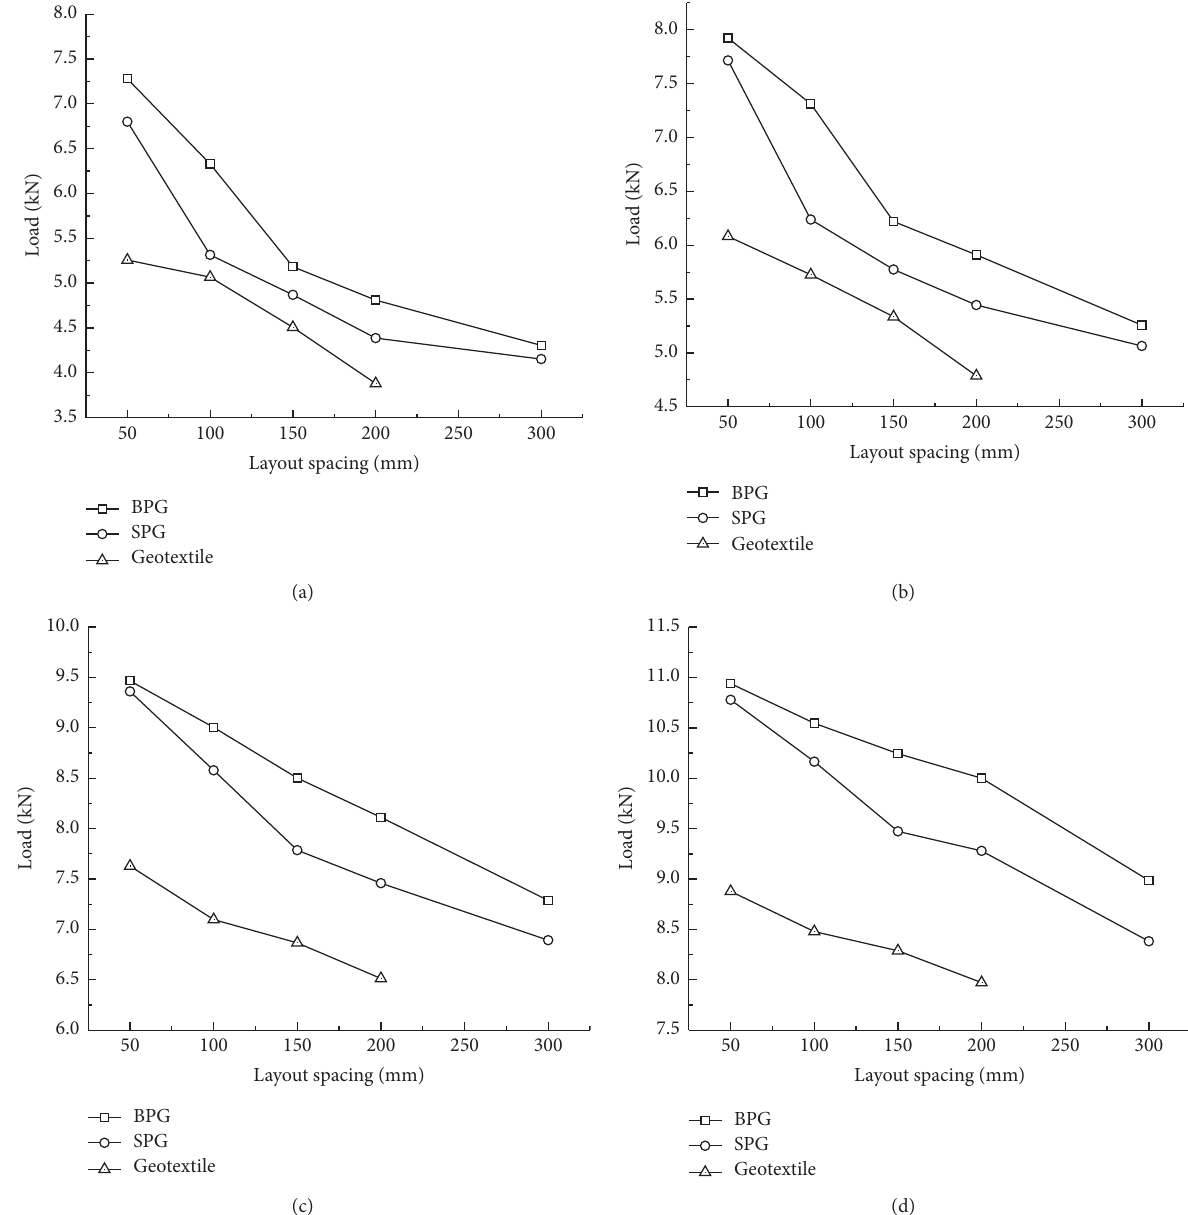
Figure 8: Schematic diagram of the interaction between factors A and B under different displacements: (a) 12mm, (b) 22mm, (c) 52mm, and (d)